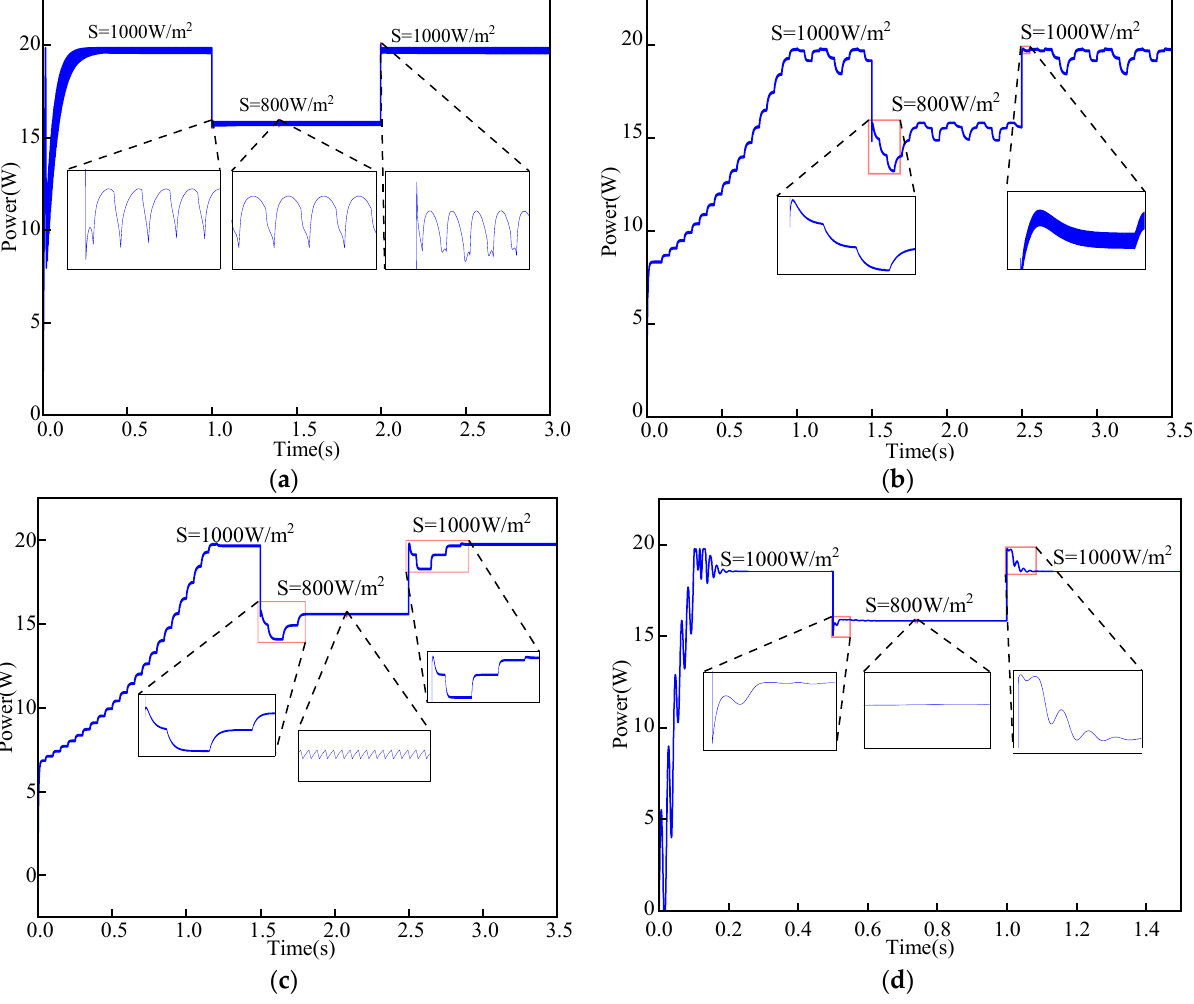
Figure 19. ( a ) Constant voltage method. ( b ) Perturbation observation method. ( c ) Constant step conductance increment method. ( d ) Three ‐ stage variable step conductance increment method based on Kalman filter.